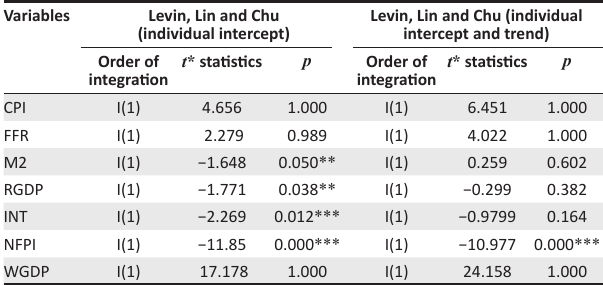
TABLE 1a: Levin, Lin and Chu, Im, Pesaran and Shin and Augmented Dickey– Fuller unit root tests. Variables Levin, Lin and Chu Levin, Lin and Chu (individual (individual intercept) intercept and